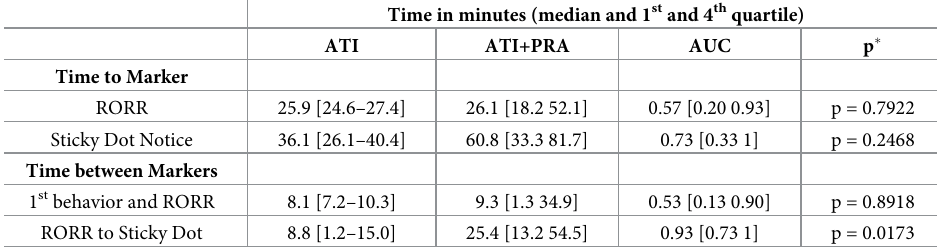
ATI: atipamezole; PRA: prazosin; RORR: return of righting reflex � p-values were calculated using the Mann-Whitney U test; AUC: area under the receiver operating curve; AUC was used as effect